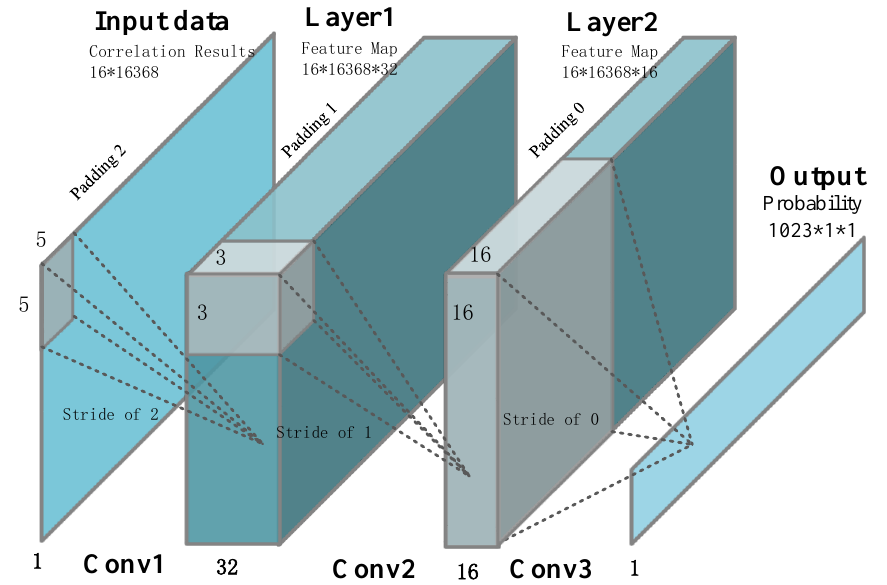
Figure 5. Envelope recognition by BCNN.